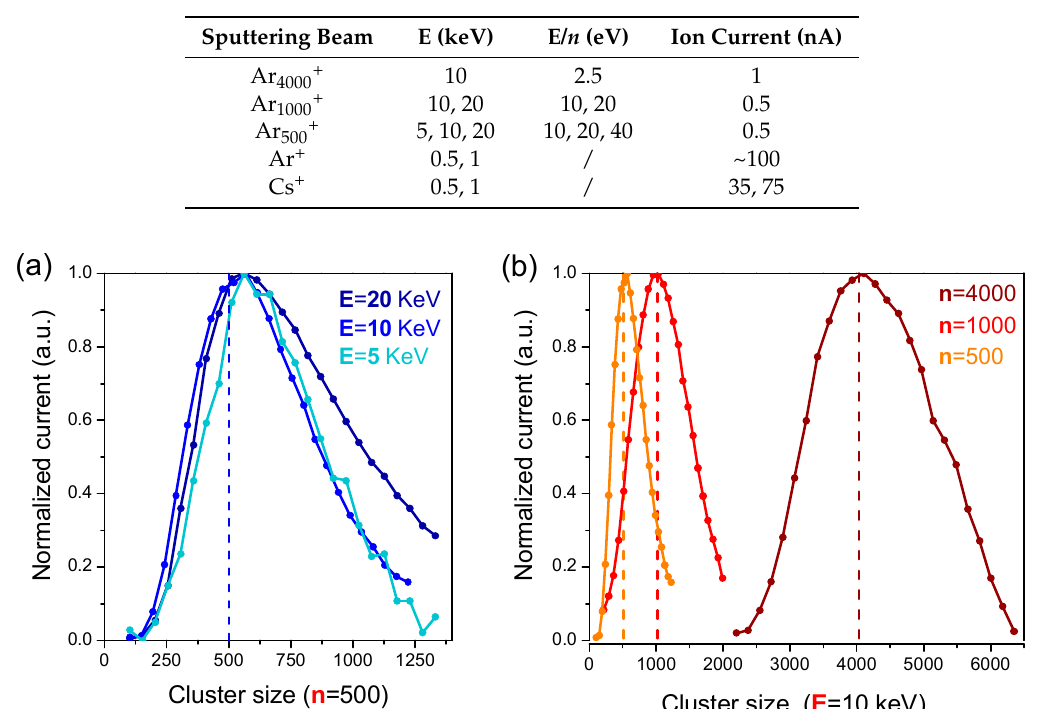
Figure 2. Size distribution ( n ) of Ar n+ clusters on the IONTOF V ToF-SIMS spectrometer at ( a ) constant nominal size ( n = 500 as indicated by the vertical line) and variable cluster energy (5 < E < 20 keV), and ( b ) fixed energy (E = 10 keV) and variable nominal cluster size (500 < n < 4000).